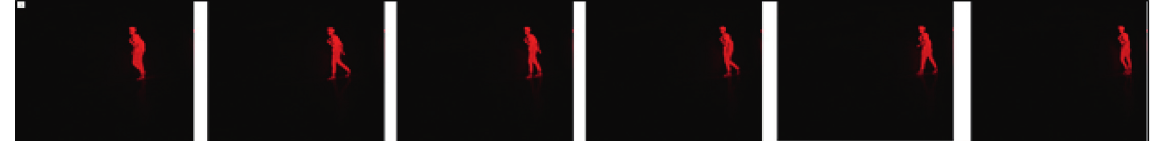
Figure 7: Gait data after foreground extraction and gait cycle detection.